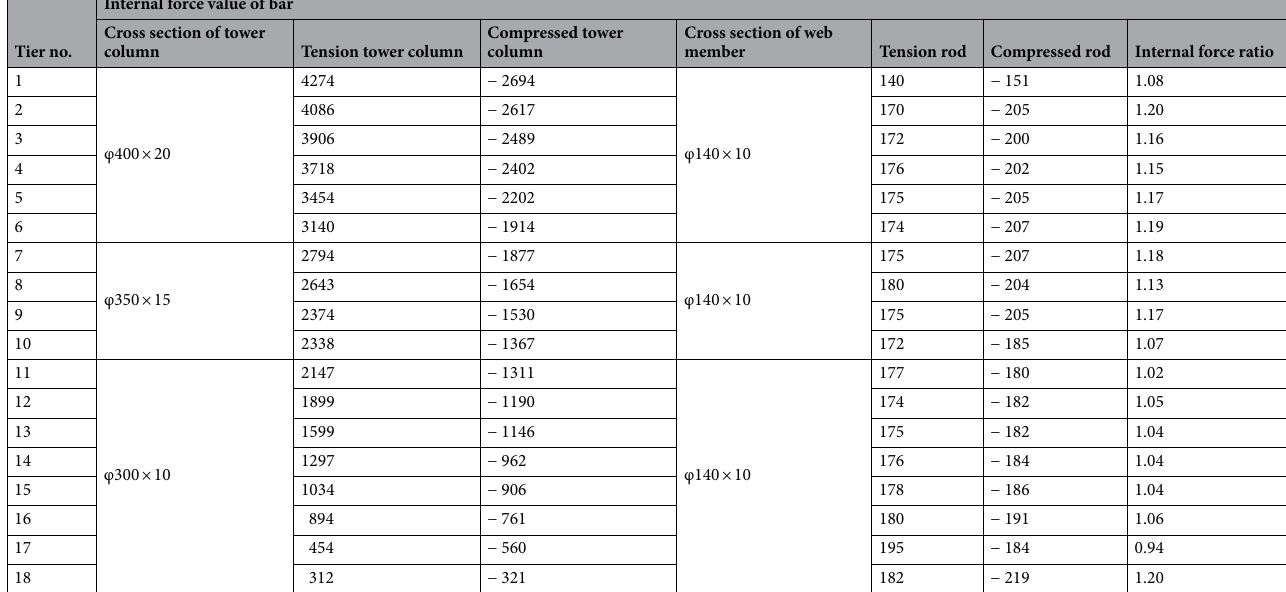
Table 1. Internal force value of